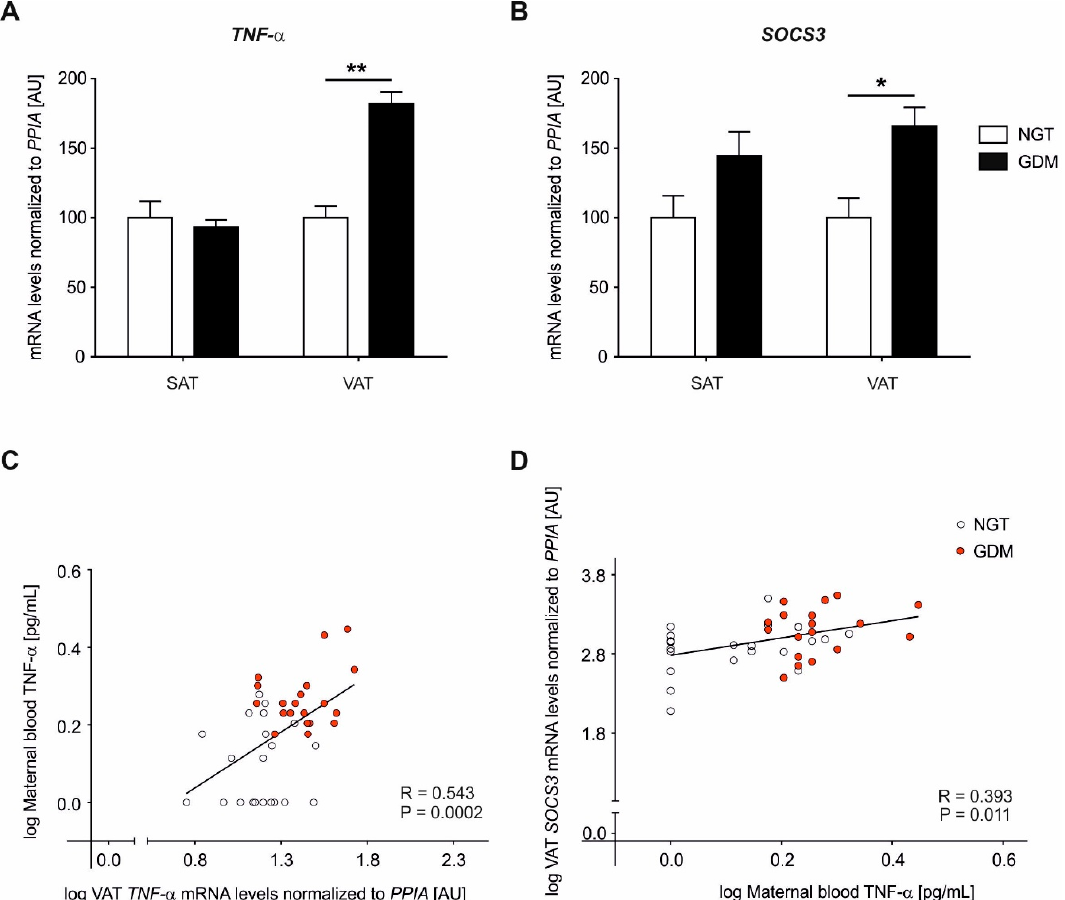
Figure 1. Relative mRNA levels of TNF - α and suppressor of cytokine signaling 3 ( SOCS3 ) in subcutaneous adipose tissue (SAT) and visceral adipose tissue (VAT) of women with GDM vs. NGT. Relative gene expression of TNF - α ( A ) and SOCS3 ( B ) was normalized to peptidylprolyl isomerase A ( PPIA ) in abdominal SAT and omental VAT, of women with GDM (n = 19, black) vs. NGT women (n = 22, white). Data are means ± SEM, shown as percentage to NGT levels. A.U., arbitrary units. TNF - α VAT ** P < 0.0001, SOCS3 -VAT * P = 0.01. ( C – D ) Pearson’s correlation coe ffi cients (R) calculating the relationship between maternal blood TNF- α levels and VAT gene expression data. NGT: open circles, GDM: red circles. Statistical significance between groups ( A , B ) and for correlations ( C , D ) remained after adjustment for prepregnancy body-mass-index (BMI) and BMI at